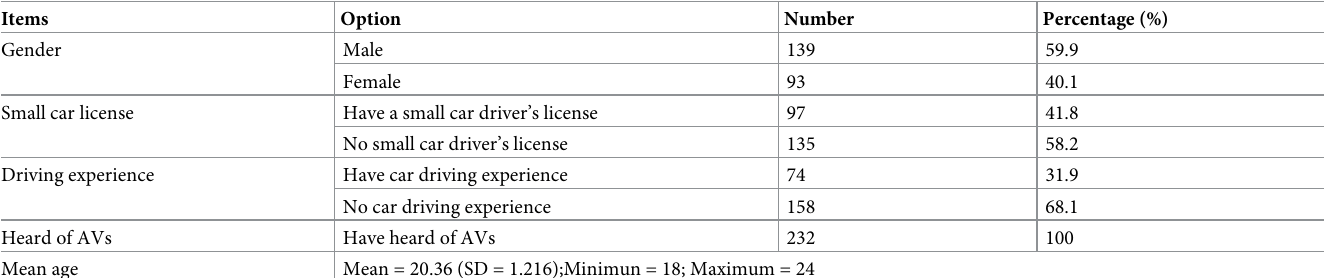
Table 1. The demographic of participants (N =